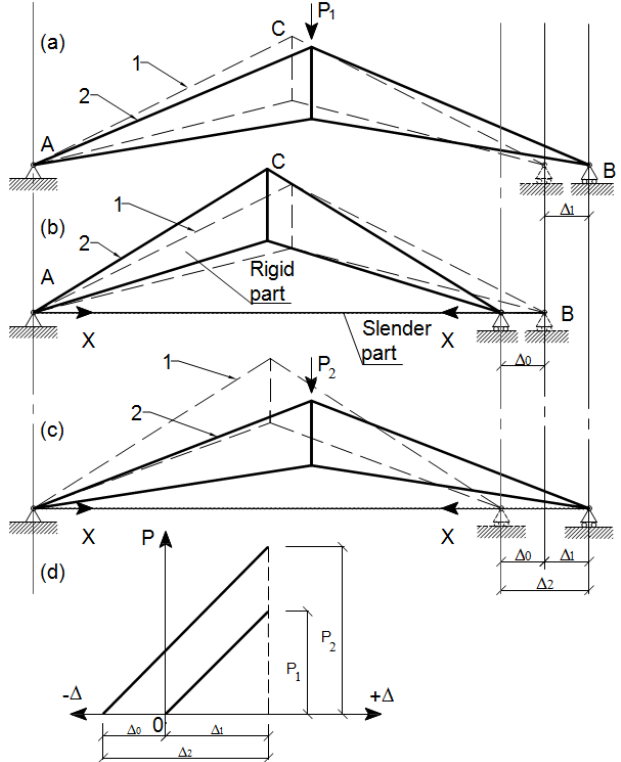
Figure 3. Hierarchy of the structural efficiency of the arched truss. ( a ) Non-prestressed truss; ( b ) prestressed truss; ( c ) loaded prestressed truss; 1 — dotted line — initial position; 2 — solid line — final position; ( d ) graph comparing the prestressed trusses ’ parameters to the non-prestressed trusses ’ parameters.